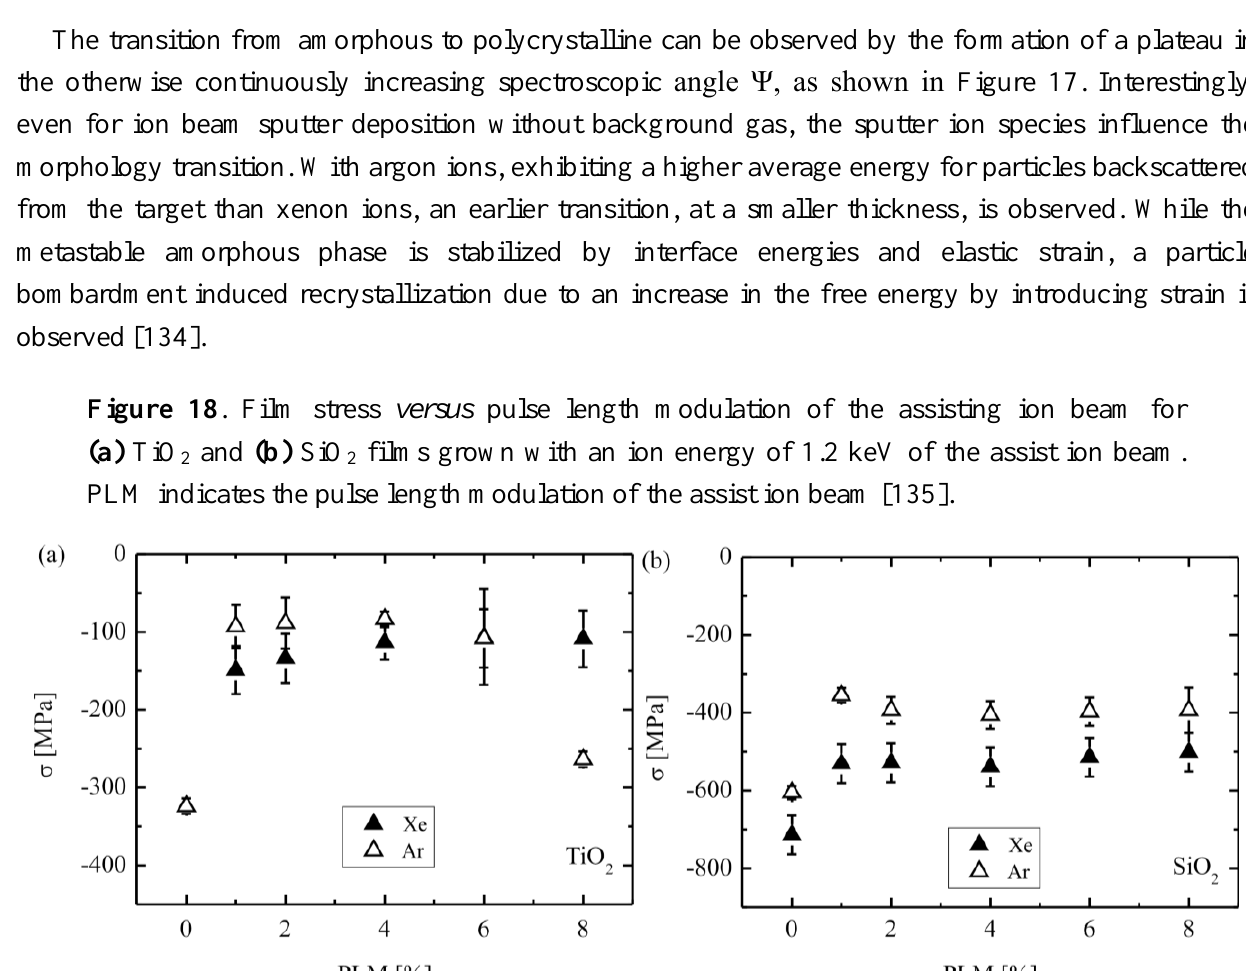
= 0.8 keV, ion = 0.8 keV, f = 3.2 sccm). The different ion Ar